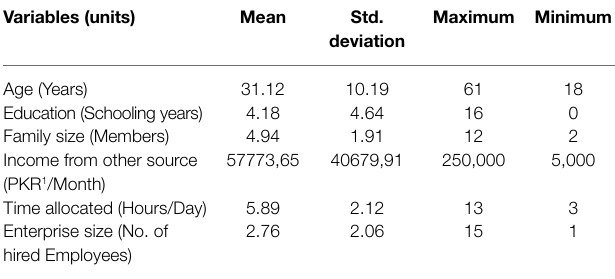
TABLE 3 | Summary statistics of the variables. Variables